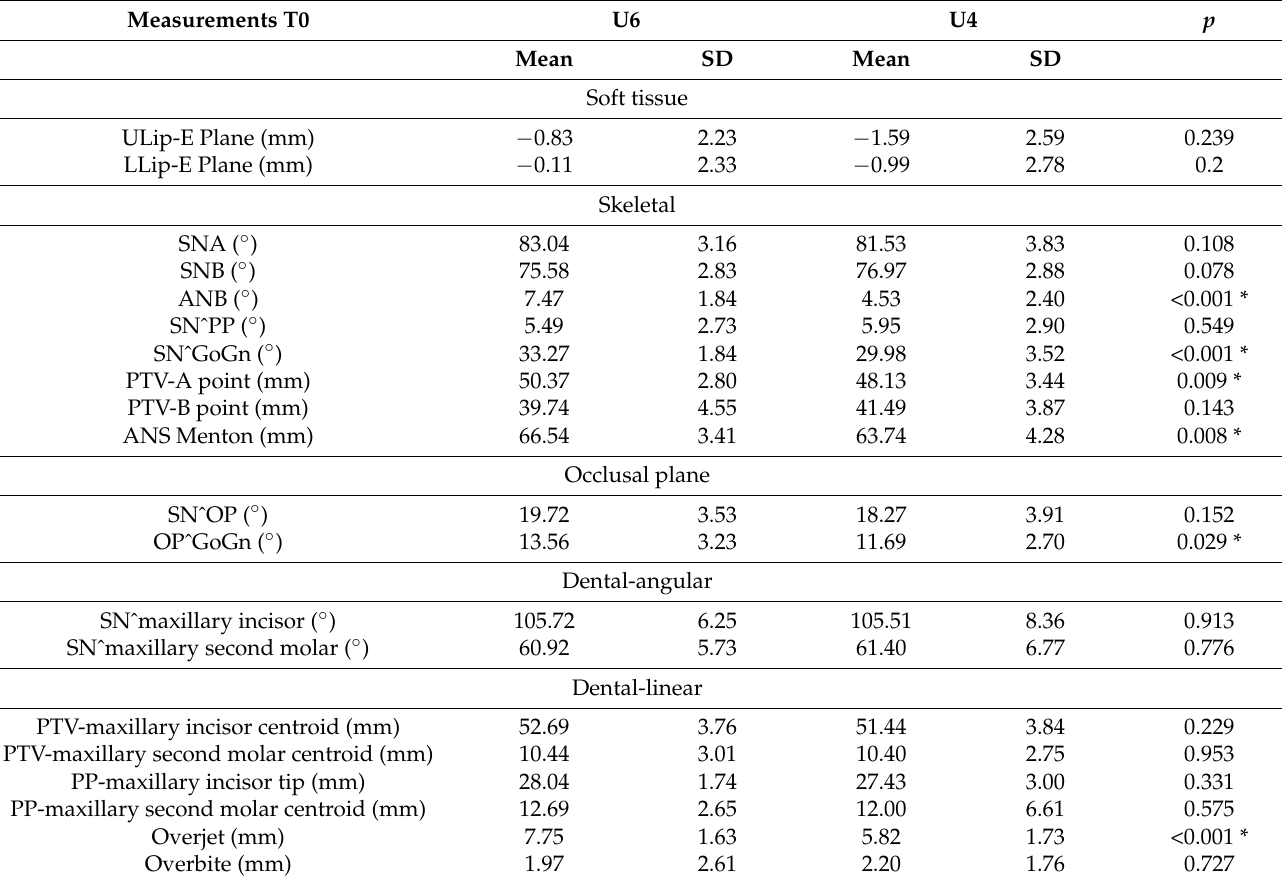
Table 1. Baseline data (T0) for the cephalometric variables; * p <